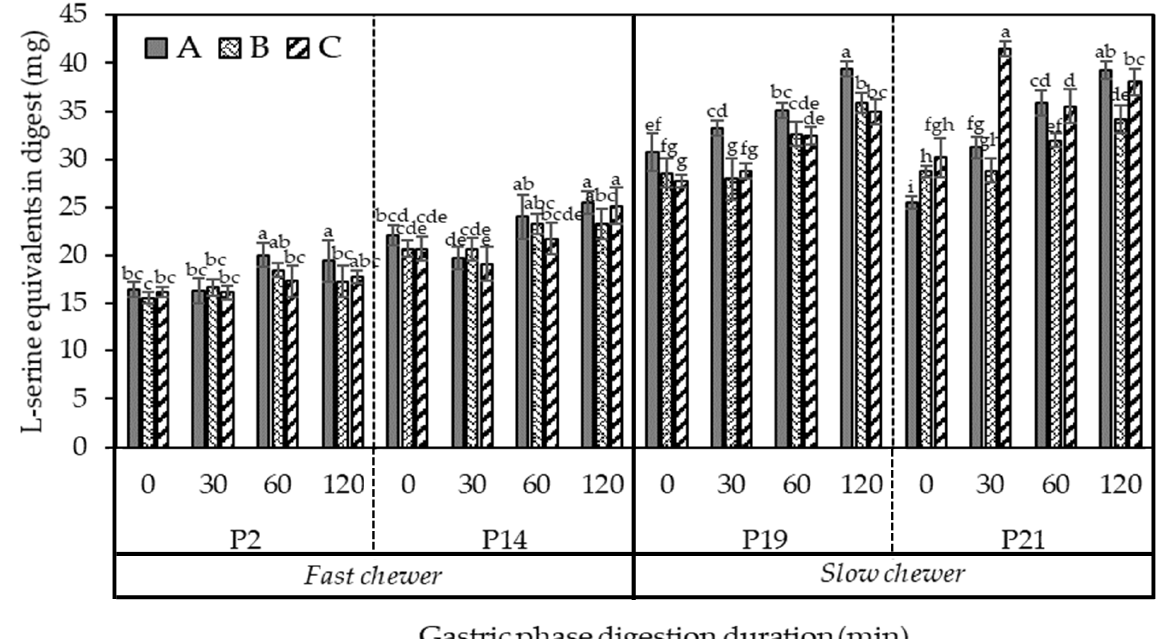
Figure 10. In vitro gastric protein digestion of in vivo masticated black bean samples (A: PEF and thermally processed without CaCl 2 addition; B: PEF and thermally processed with CaCl 2 addition; and C: No PEF, thermally processed with CaCl 2 ) from selected fast and slow chewers. Data presented as mean ± standard deviation ( n = 8 measurements). Values with different letters within each participant are significantly different ( p < 0.05) with increasing digestion time.